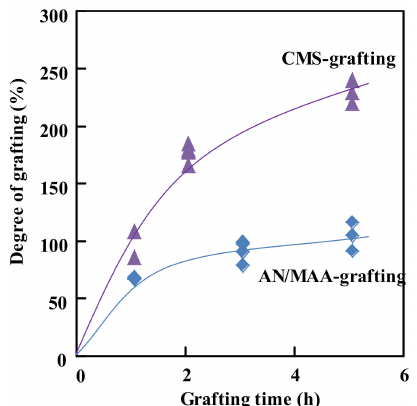
Figure 2. Radiation grafting of AN/MAA and CMS onto the PE/PP nonwoven fabrics in nitrogen gas. Preirradiation dose, 100 kGy for AN/MAA grafting and 50 kGy for CMS grafting; grafting temperature, 40 ◦